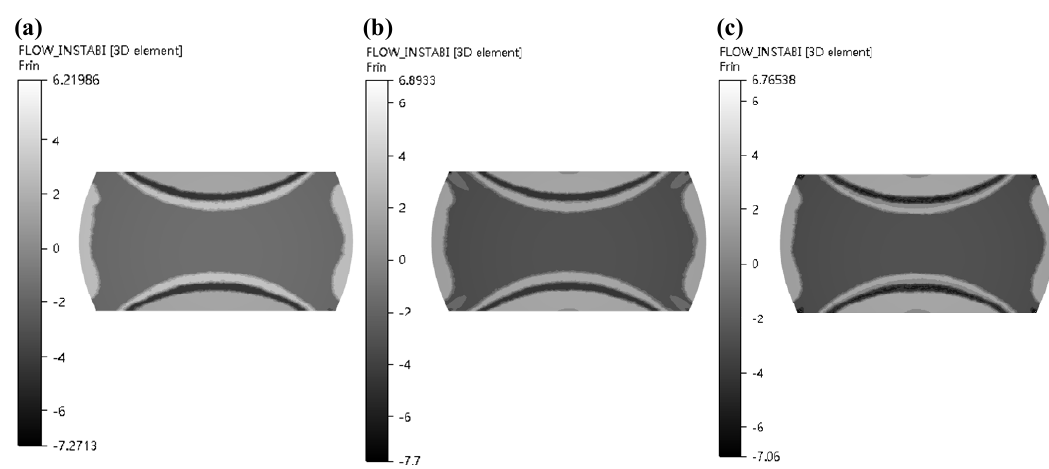
Figure 17. Distributions of ξ (instability coe ffi cient) in the condition of 1050 ◦ C / 0.7 (T = 1050 ◦ C, ε = 0.7) under various strain rates: ( a )